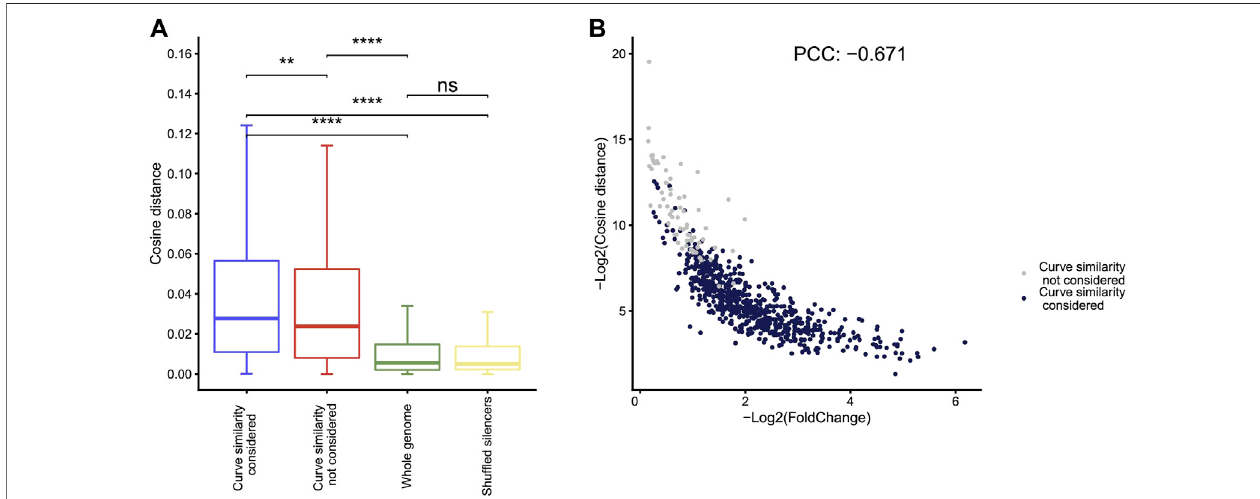
FIGURE 4 | Curve similarity effect on silencer identi fi cation. (A) The cosine distance distribution for silencers identi fi ed by Fast-NR with similarity considered, similarity not considered, and controls of whole genome regions with 400 bp size and shuf fl ed silencer regions. Distance negatively correlates with similarity. ** p < 10 − 3 , *** p < 10 − 4 , Wilcoxon rank sum test. (B) The correlation between silencer strength and curve similarity. The X axis shows the value of − log 2 (cDNA reads/insert DNA reads). The Y axis shows the curve similarity index, − log 2 (Cosine distance) of silencers calculated by the method of cosine. Blue dots are silencers that pass curve similarity threshold of 0.9, and gray dots are silencers that do not pass curve similarity